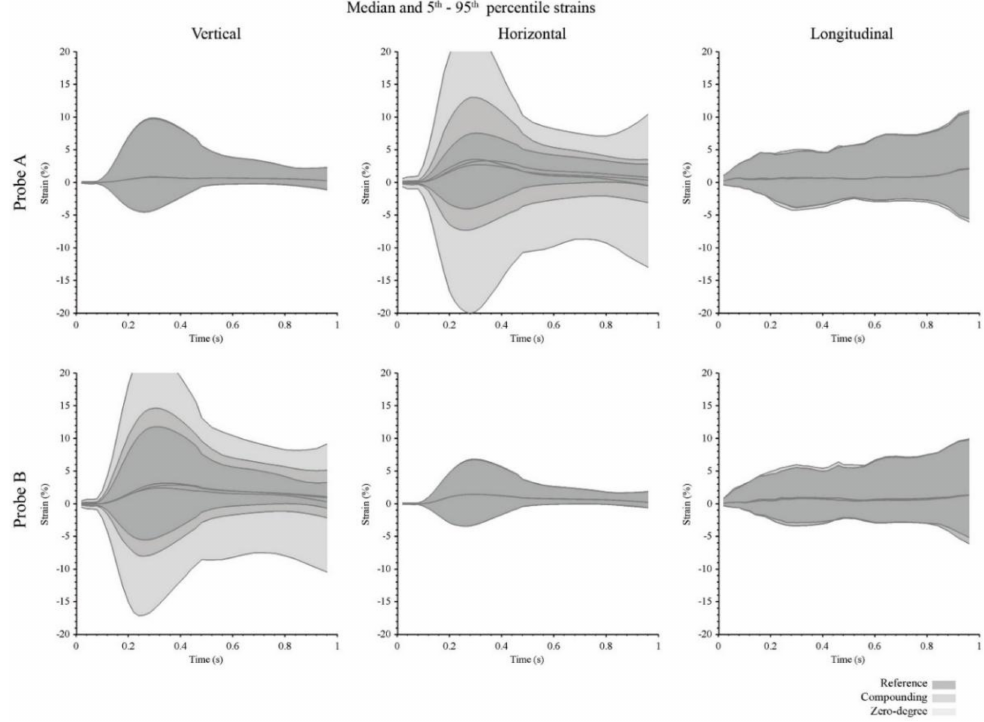
Figure 9. The vertical, horizontal, and longitudinal strain range (median and 5th–95th percentile) for the complete cardiac cycle for the reference, compounding, and zero-degree method for probe A and B.